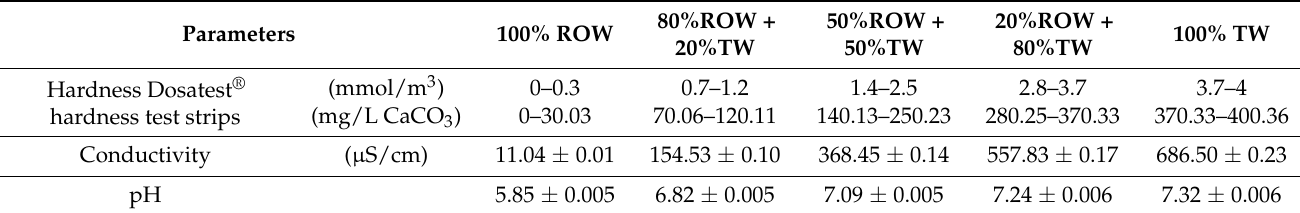
Table 1. Measured hardness, conductivity and pH of the water media used for rearing Aedes mosquitoes in the present experiment. Conductivity and pH values are expressed as mean ± SE. ROW = reverse osmosis water, TW = tap water. Parameters